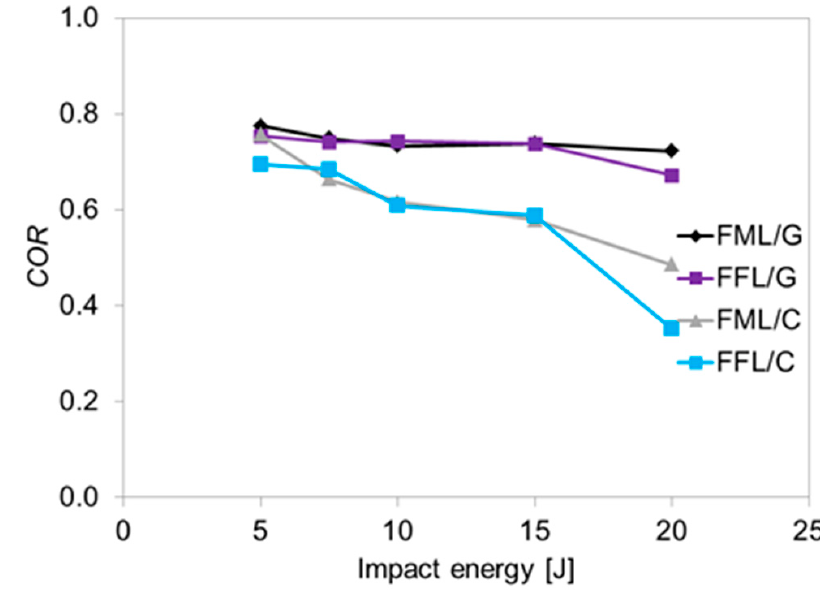
Figure 8. COR coefficient vs. impact energy for all laminates.